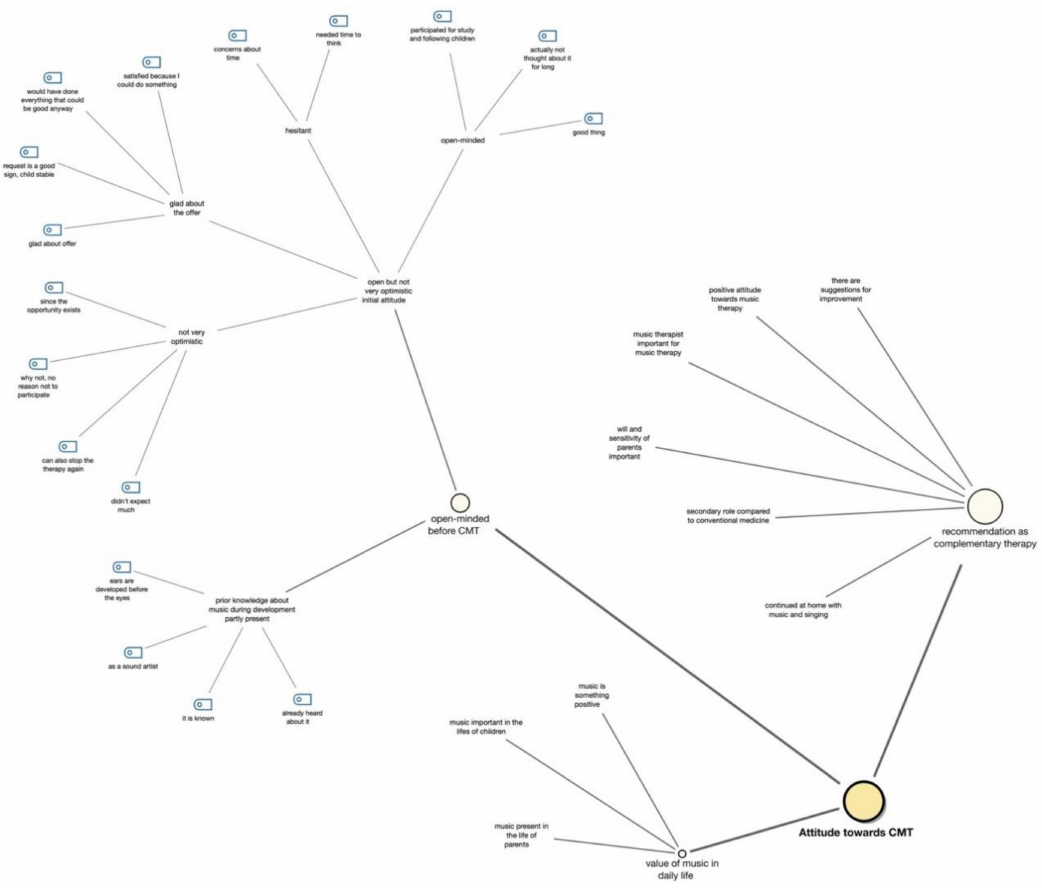
Figure A2. Detailed Coding